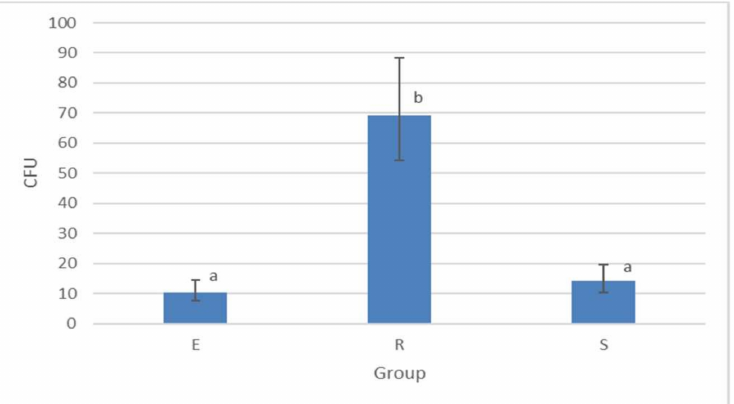
Figure 3. Mycobacterial load comparison detected by culture examination in three clusters. Figure interpretation. CFU = colony-forming units, Cluster E = faeces and animals’ samples, Cluster R = peat and plant material, and Cluster S = soil and water sediments. The columns represent geometric means of CFU; vertical bars correspond to 95% confidence intervals of these means. Letters above columns denote statistically significant differences ( p < 0.05 at least) among groups (columns sharing the same letter are not significantly different from each other; columns that had no letter in common are significantly different from each other).